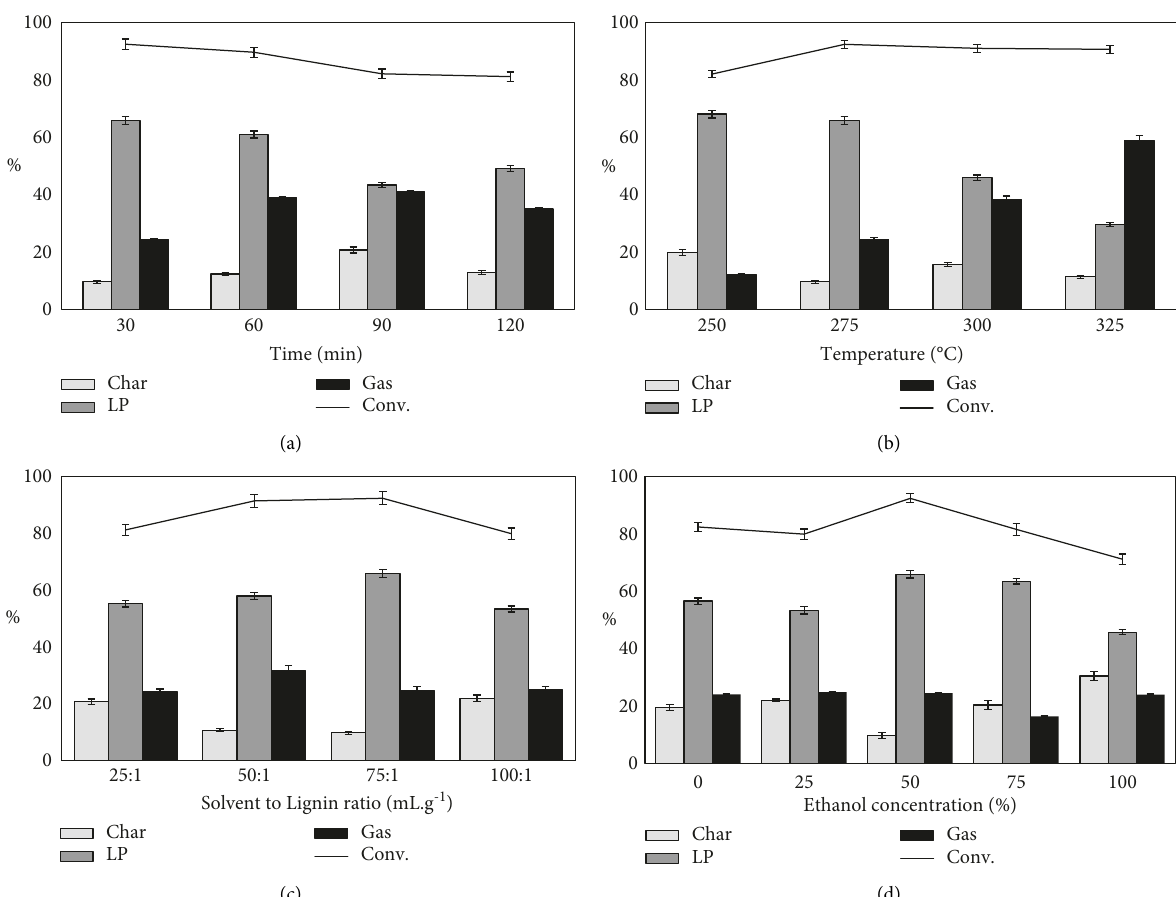
Figure 3: The effects of reaction conditions on the product distribution and conversion rate of rice straw